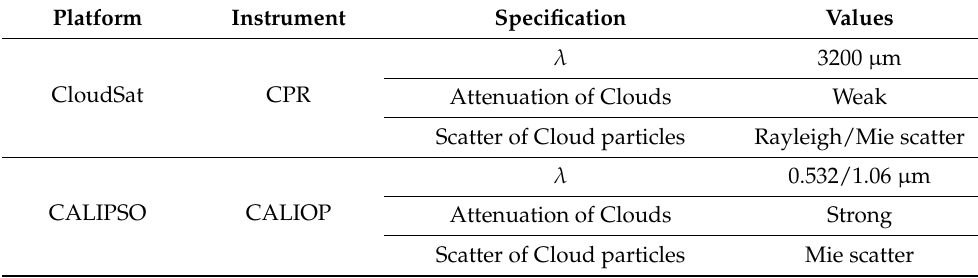
Table 1. Satellite information.